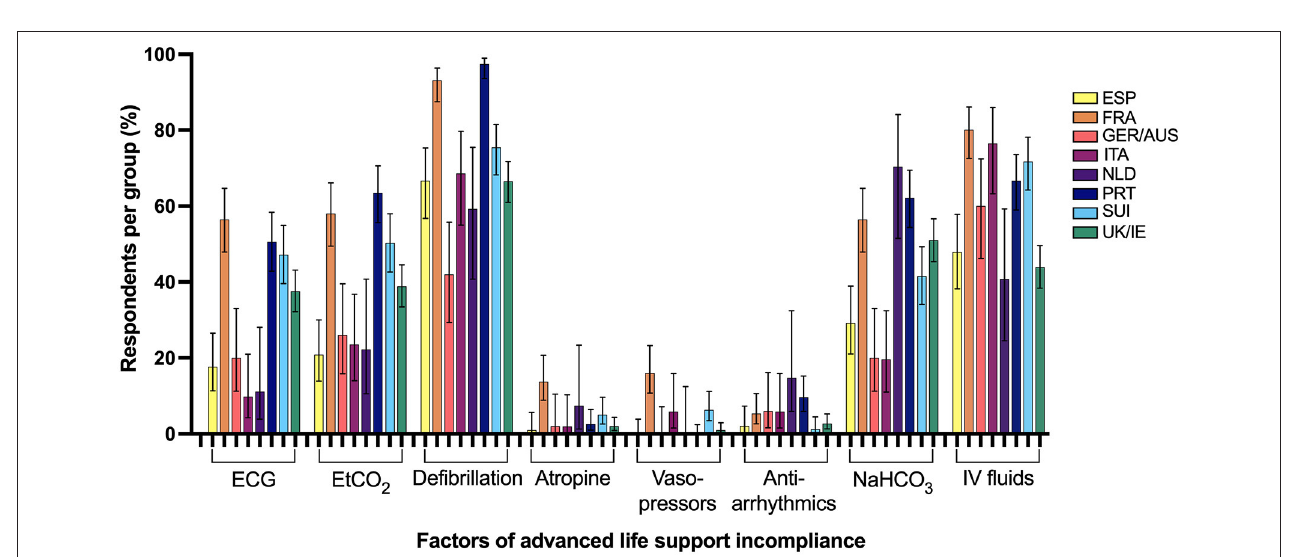
FIGURE 5 | Percentage of respondents from 8 Western European regions incompliant with advanced life support RECOVER guidelines and the associated factors for failed compliance. ECG, Electrocardiogram; ESP, Spain; EtCO 2 , End-tidal carbon dioxide; FRA, France; GER/AUS, Germany/Austria; ITA, Italy; NaHCO 3 , sodium bicarbonate; NLD, Netherlands; PRT, Portugal; SUI, Switzerland; UK/IE, England/Northern Ireland/Scotland/Wales/Ireland; IV,